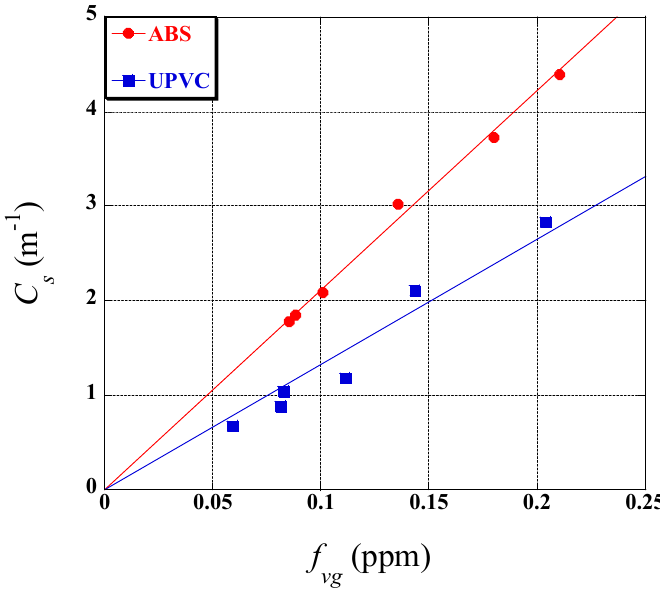
Figure 5. Light obscuration plotted as a function of smoke volume fraction.